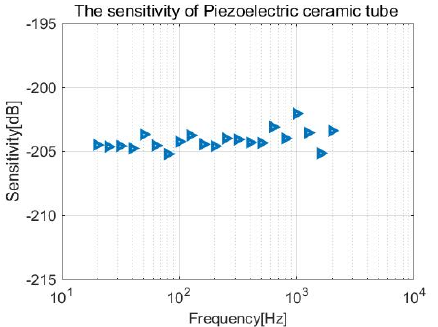
Figure 18. Sensitivity of scalar channel (the piezoelectric ceramic tube).